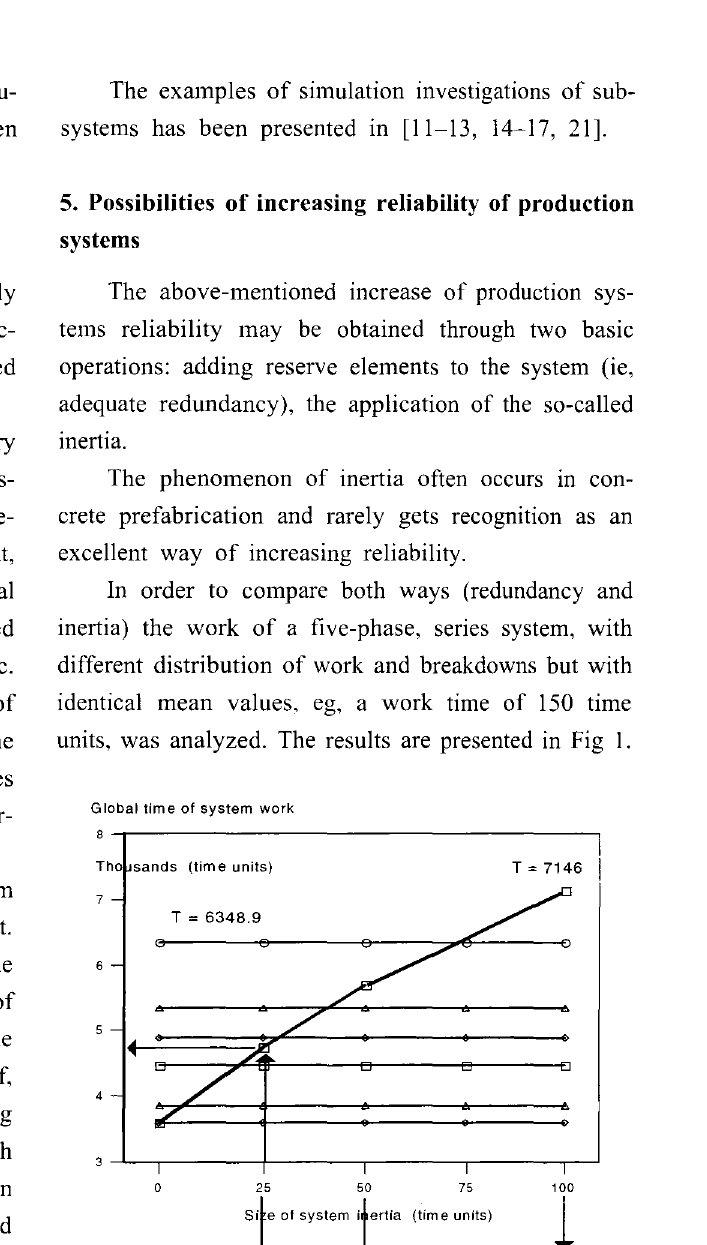
Fig 1. Comparison of the redundancy method and iner tia method The horizontal lines indicate the value of the system's global work time with a different number of redundancies (from I to 10). The oblique line indicates the system with inertia. Notice that only a 16% inertia (in relation to the mean work time of the phase) gives